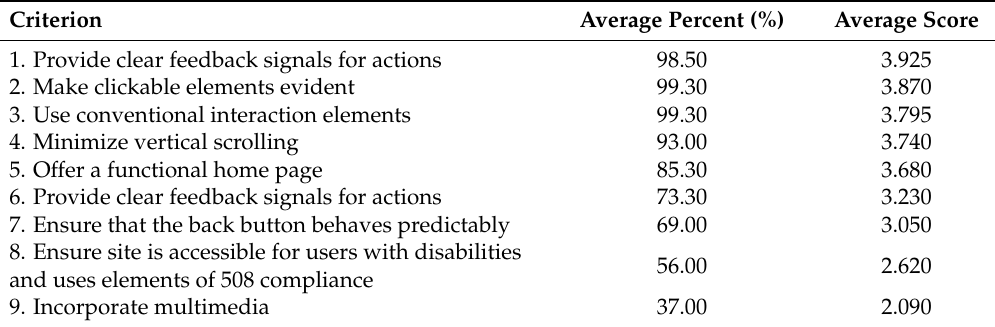
Figure 4. Percentage of websites in terms of convenience in user interaction. Table 4. Estimated percentages of websites in compliance with the criterion of site design.